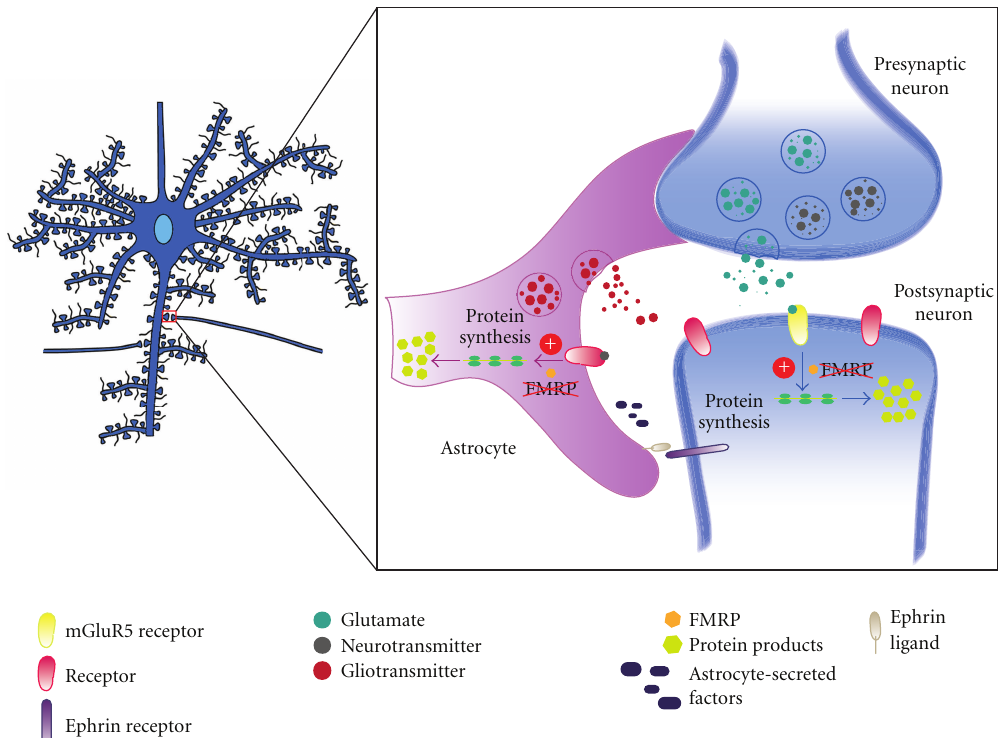
Figure 1: The role of astrocytes in FXS. It is becoming increasingly apparent that, in addition to presynaptic terminals and postsynaptic dendritic spines, synapses contain a third element: the fine processes of the astrocyte, which intimately enwrap the first two